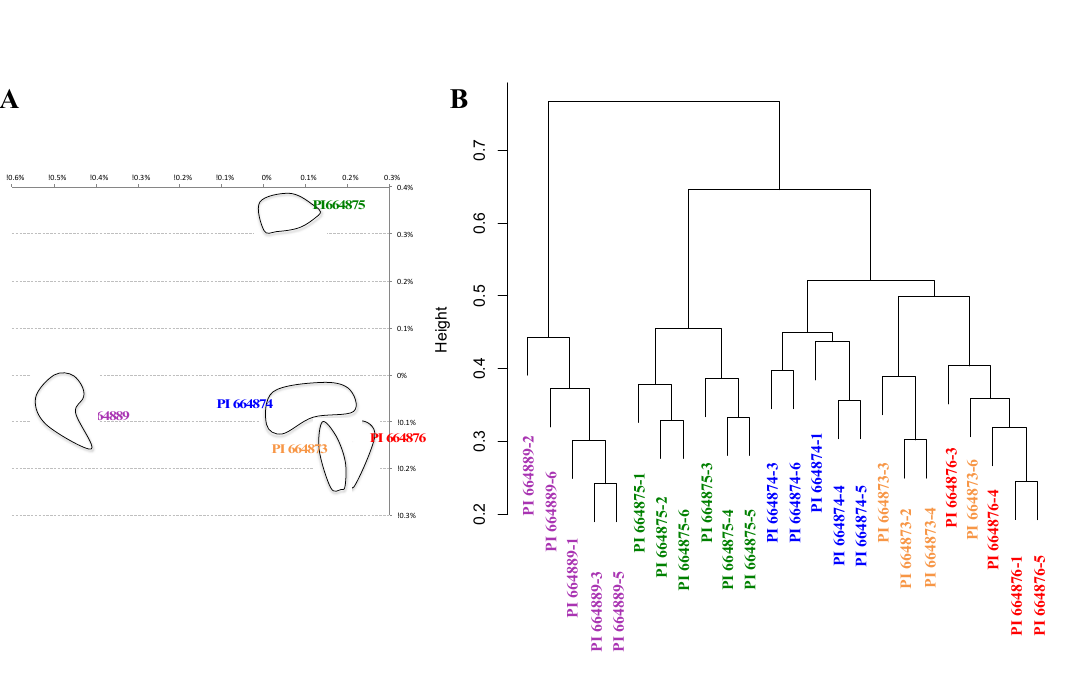
Figure 10. Statistical distances among Prunella accessions based upon cuticular lipid profiles from vegetative organs of